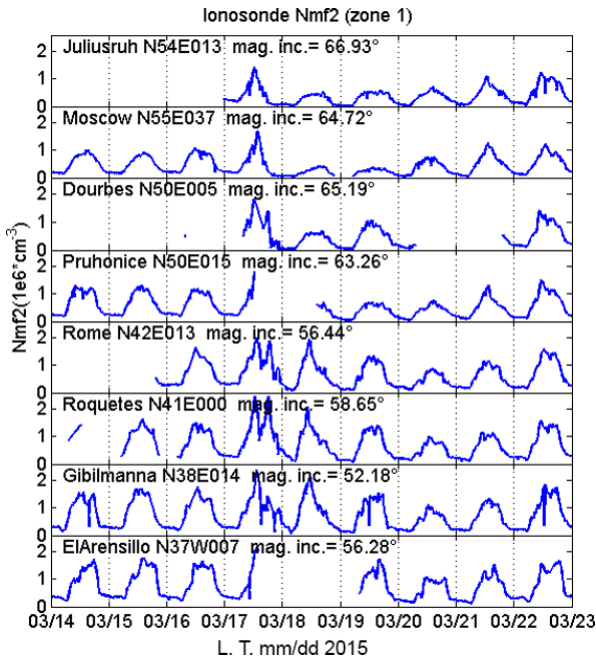
Figure 9. Variations in NmF2 at eight ground ionosonde stations located in zone 1 during the magnetic storm of March 2015. Ionosonde data were obtained from SWPC.